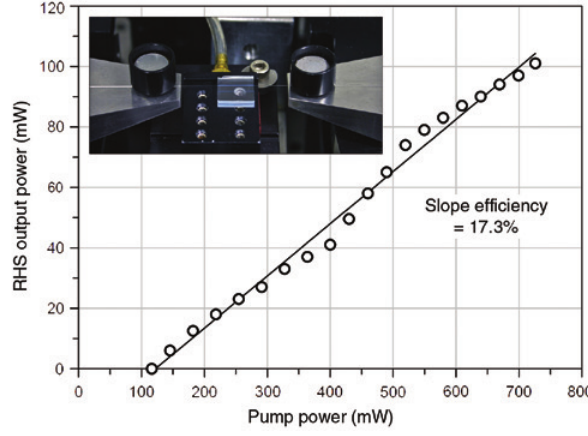
Figure 19: Transmission spectrum of a phase-modulated sampled WBG fabricated in Yb-doped phosphate glass using the modulated burst ULI method.